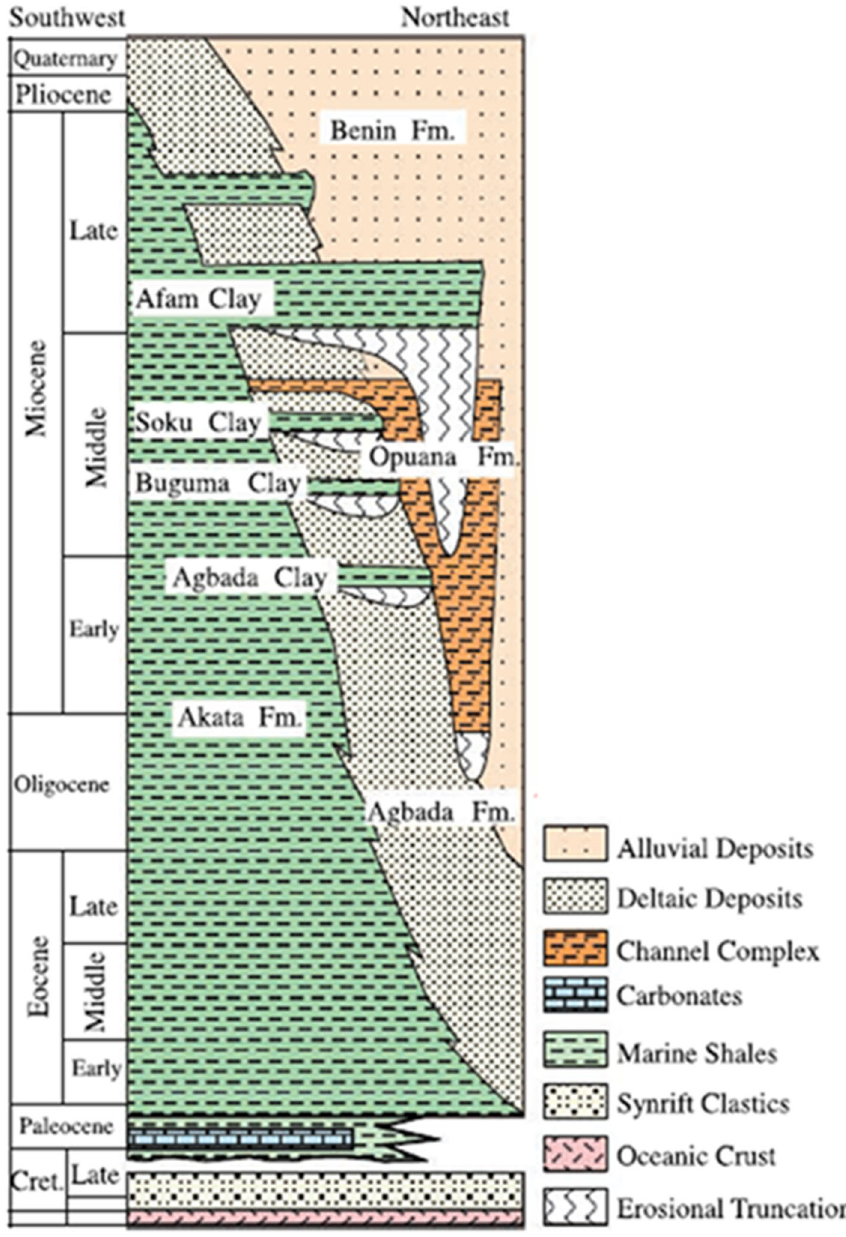
Fig. 3 Stratigraphic column showing Formations in the Niger Delta (Tuttle et